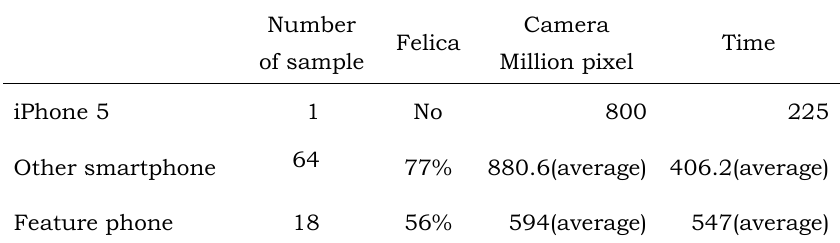
Table 2. The average of different type of mobile phone